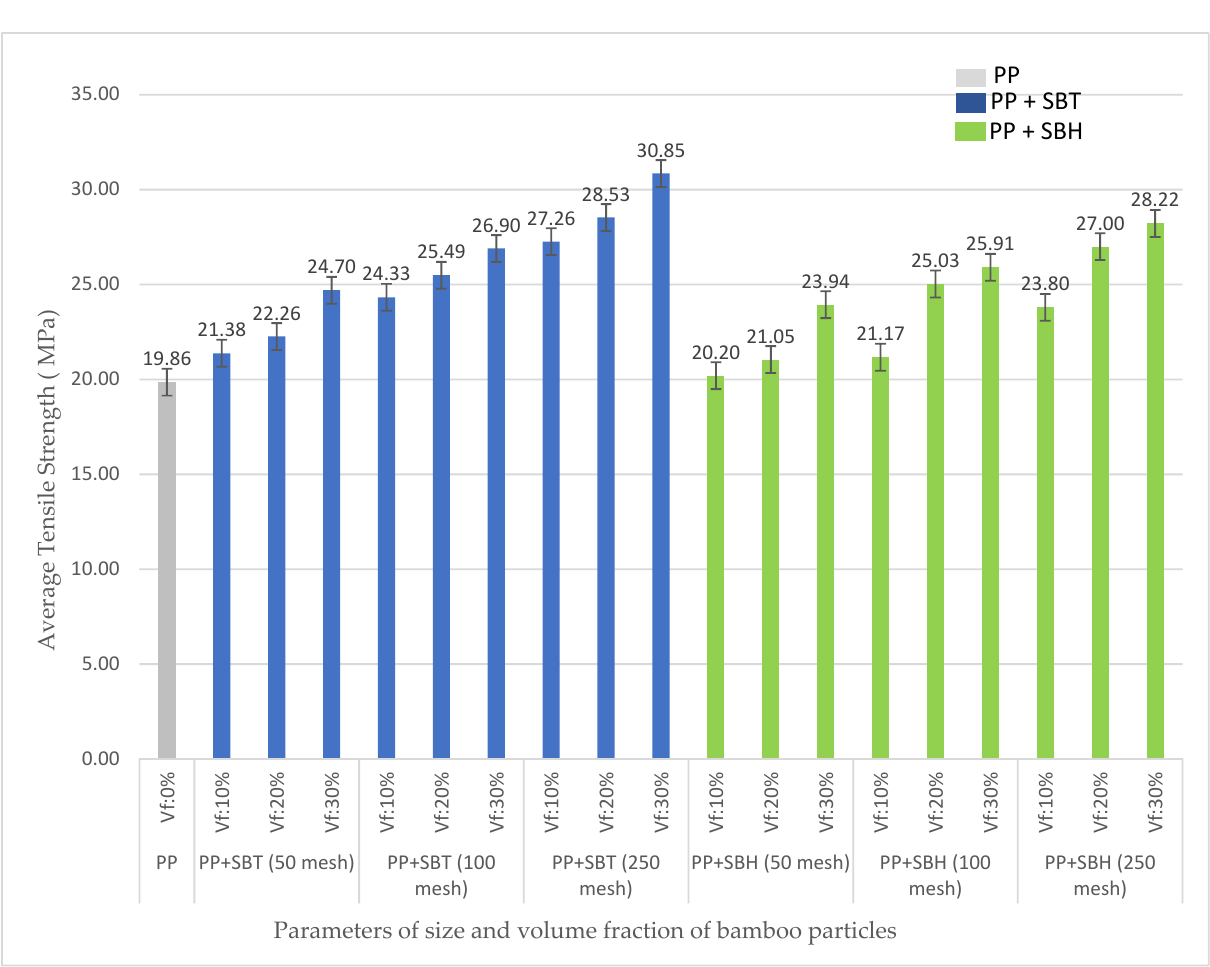
Figure 10. Relationship between volume fraction on the particle size of SBT and SBH polyester (PP) matrix on tensile strength.